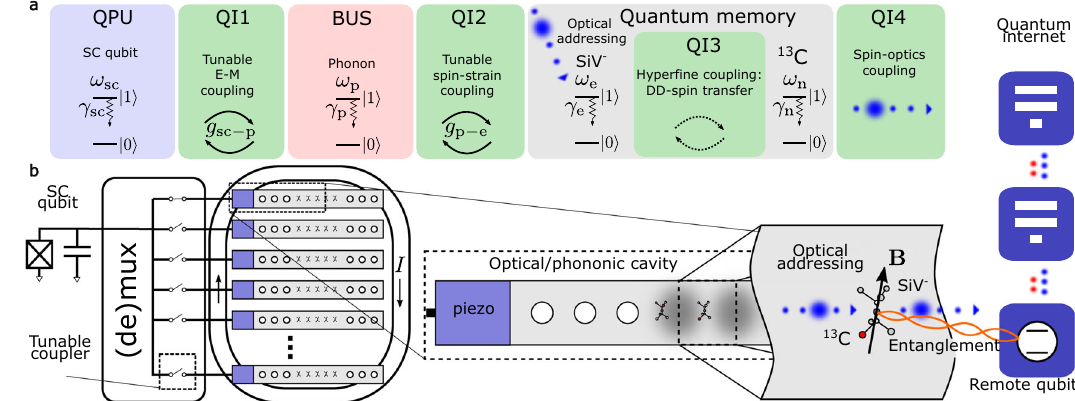
Fig. 1 Quantum memory (QM) and interconnect architecture. a An SC quantum processing unit (QPU) is connected via piezoelectric `quantum interface 1' (QI1) to a phononic BUS. The phonon couples to electronic spin-orbit states of an AA, forming quantum interface 2 (QI2). The AA ’ s fi ne-structure states can further couple to nuclear-spin to realize a QM via quantum interface 3 (QI3) or they connect to photons in quantum interface 4 (QI4), which fi nally connects to the quantum internet (blue dots: photonic interconnects). b A physical realization of the scheme outlined in a . A superconducting qubit is connected via a phononic or microwave multiplexer (mux) to a series of phononic or microwave waveguides that are each interfaced with a mechanical cavity hosting one or many AAs whose electronic fi ne- structure (spin-orbit) states serve as qubits. The spin-orbit states of each AA interacts with the spin states of a nearby 13 C nucleus via the hyper fi ne interaction, providing ancillae qubits with long coherence times. The AA optical transitions provide an optical interface to quantum networks, for example by multiple attempts of photon-based electron spin entanglement to provide an on-demand entanglement resource. Underlying these capabilities is a transduction scheme that exploits: tunable electro-mechanical (E-M) coupling between the SC qubit and the mechanical mode, tunable spin-strain coupling between the mechanical mode and the electron spin, optical addressing of the electron spin, and hyper fi ne coupling to connect the electron spin to the nuclear